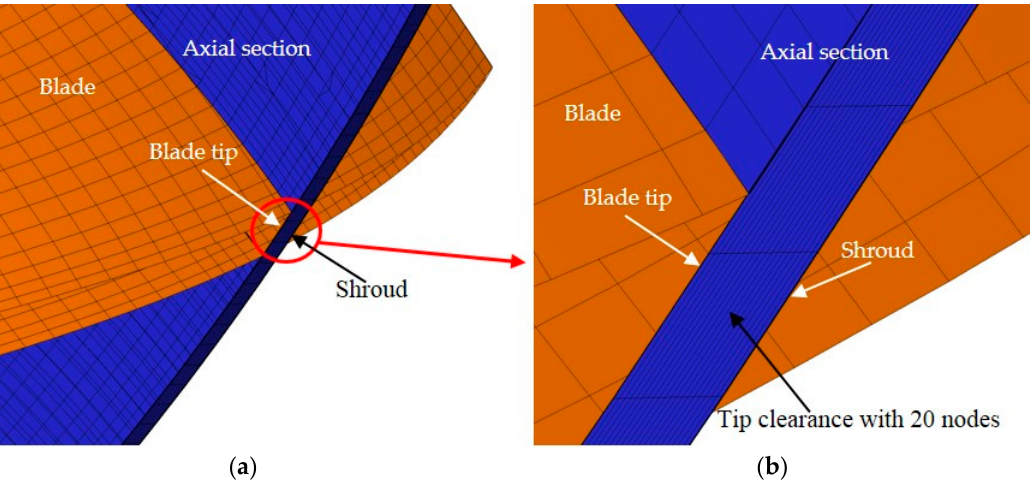
Figure 3. Local mesh encryption in tip clearance region. ( a ) Axial section; ( b ) Mesh in tip clearance